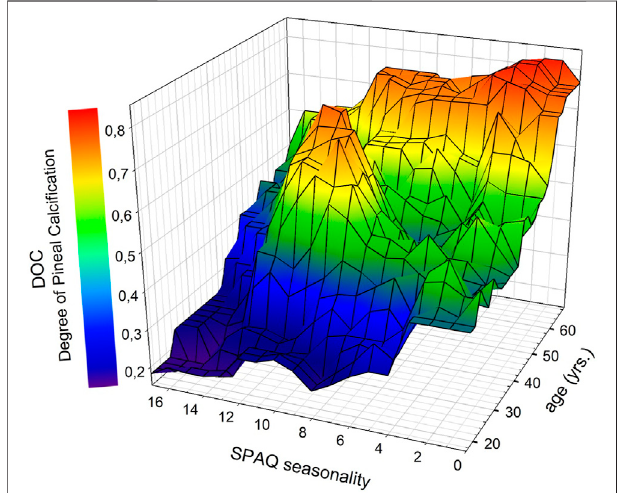
FIGURE 4 | Associations between DOC scores (degree of pineal calci fi cation), SPAQ seasonality scores, and age. Data were plotted with SigmaPlot as 3D mesh plots, smoothed with moving averages on sampling proportion of 0.1 using the bandwidth method of nearest neighbors. Colors represent DOC scores as indicated in the legend. * Signi fi cant age- independent correlation between seasonality and DOC (partial correlation: r 94 (cid:1) − 0.214; p (cid:1) 0.036). Abbreviations: SPAQ, Seasonal Pattern Assessment Questionnaire (Kasper et al., 1989): higher scores indicate more pronounced seasonality; DOC: higher scores indicate more pronounced calci fi cation (Kunz et al.,